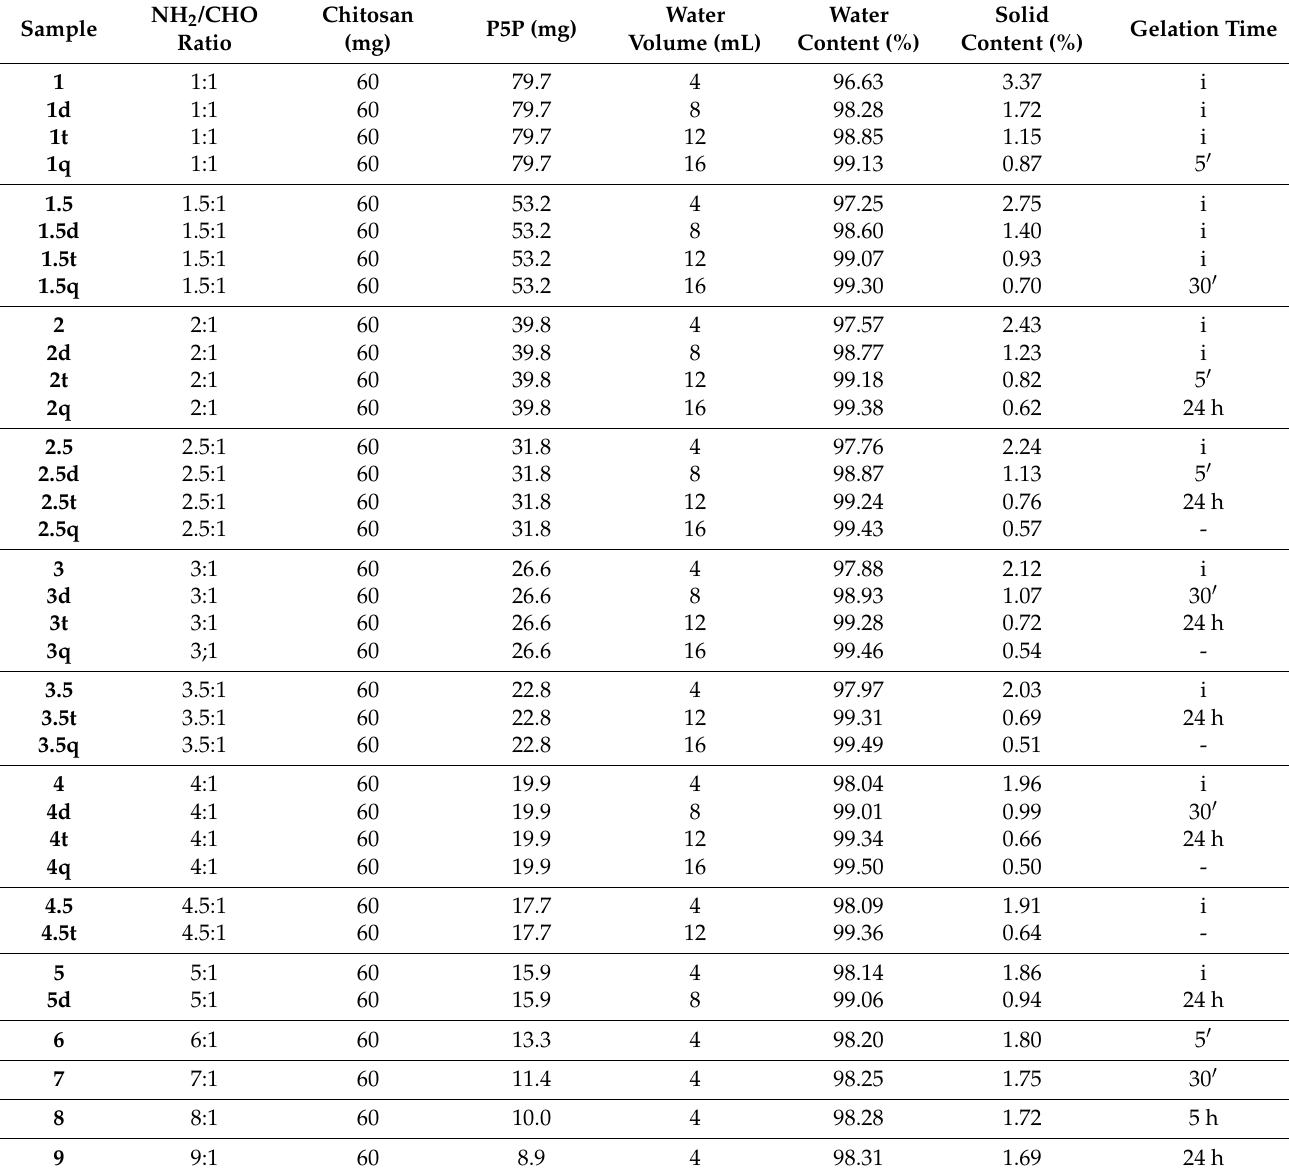
Table 1. The composition of hydrogels and gelation